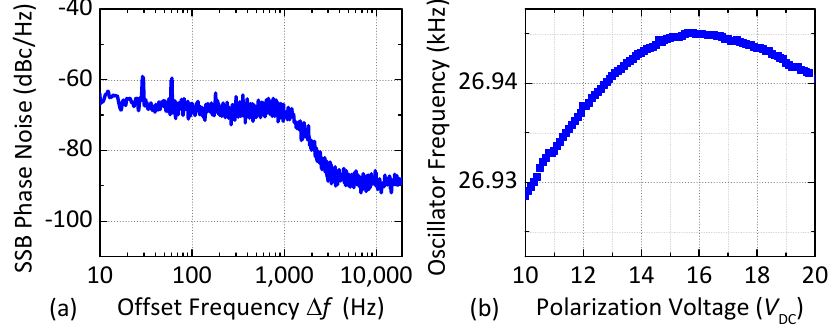
Figure 6. ( a ) Measured single-sideband (SSB) phase noise of the single-crystal SOI MEMS oscillator for V DC = 20 V; ( b ) Measured variation of the oscillation frequency as a function of V DC (approximately − 1 Hz/V for voltages >16 V).